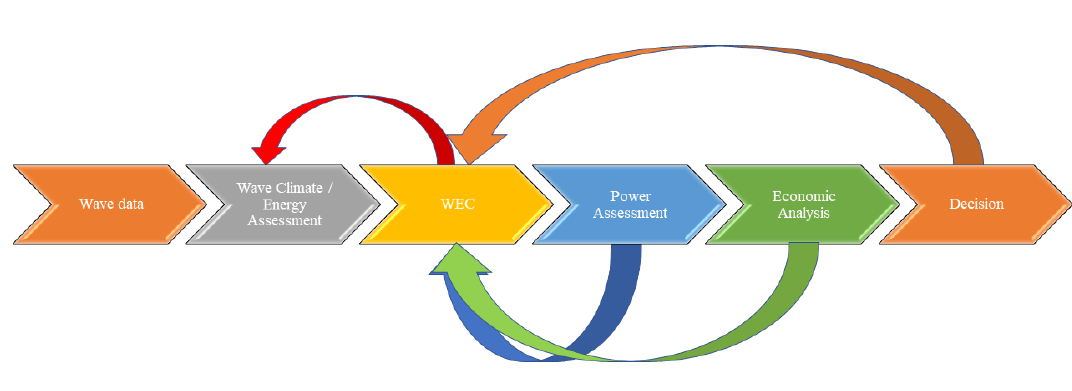
Figure 1. Linear process for the selection of suitable